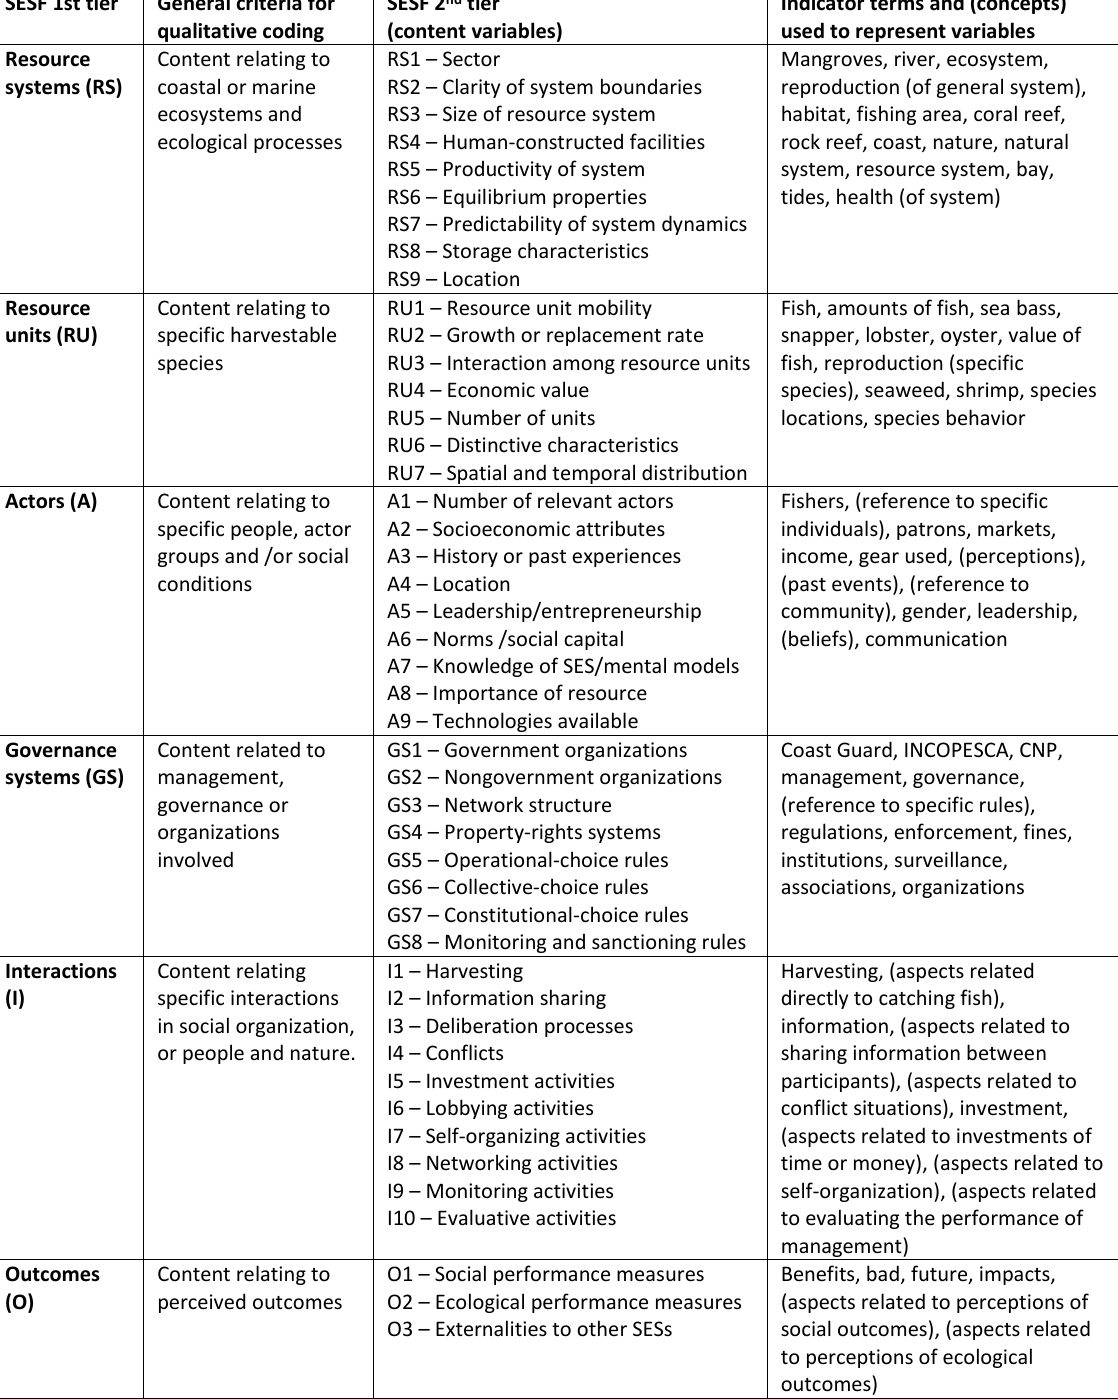
Table A1.1 Indicators used, and their corresponding SESF variables, to measure the content of deliberation